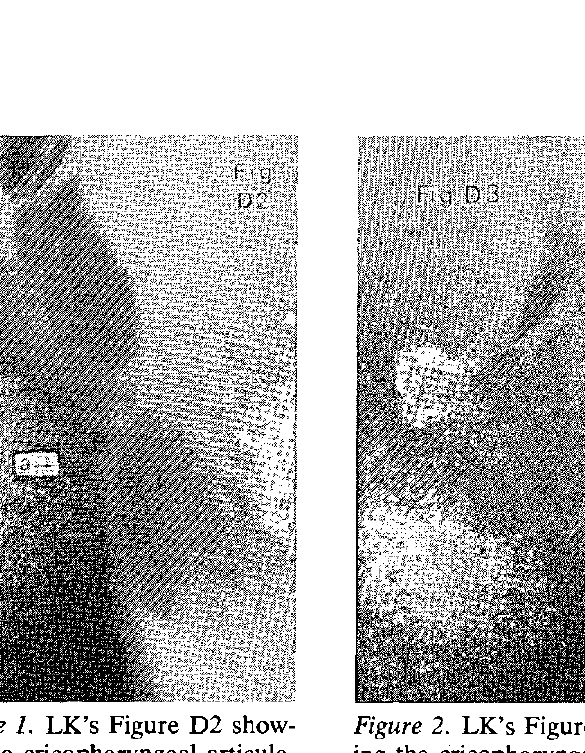
Figure 2. LK's Figure D3 show- ing the cricopharyngeal articula- tion during high-pitched eso- phageal